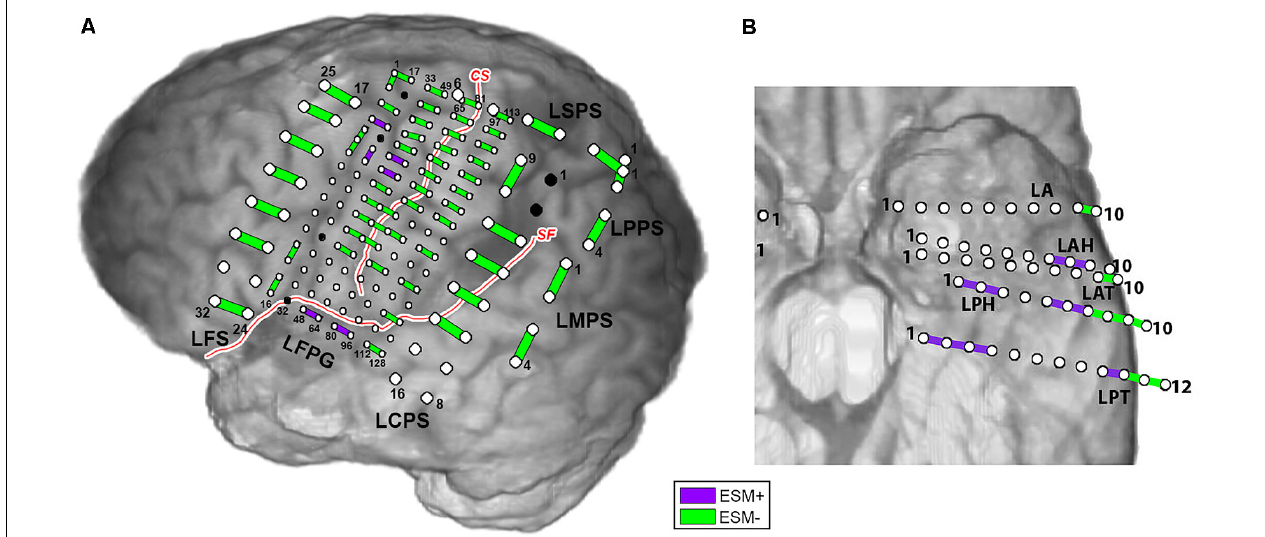
FIGURE 1 | Electrocortical stimulation mapping (ESM) results for Patient 2 (A) and Patient 5 (B) . Purple bars indicate electrode pairs that were positive during any language task (ESM+); green bars indicate those that were negative during all language tasks (ESM − ). Red curves with white stroke represent anatomical landmarks—central sulcus (CS) and sylvian fissure